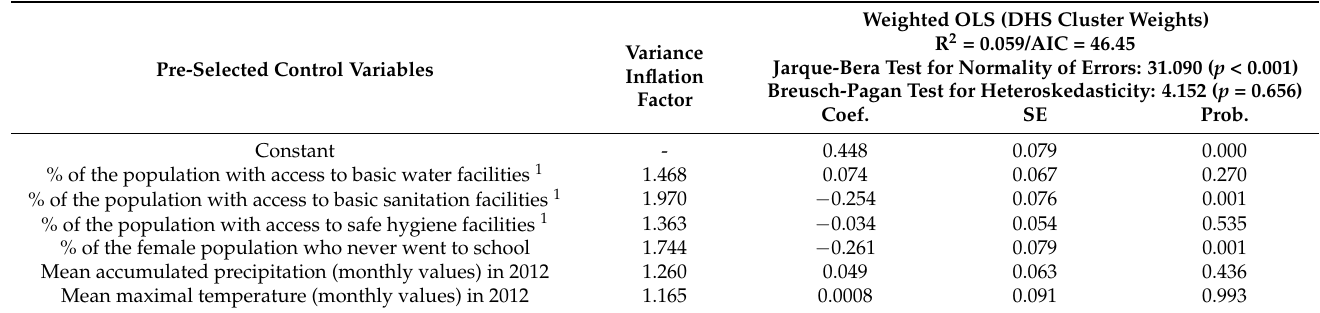
Table A3. Results of the weighted OLS regression models for the pre-selected control variables (full dataset, n = 267 spatial